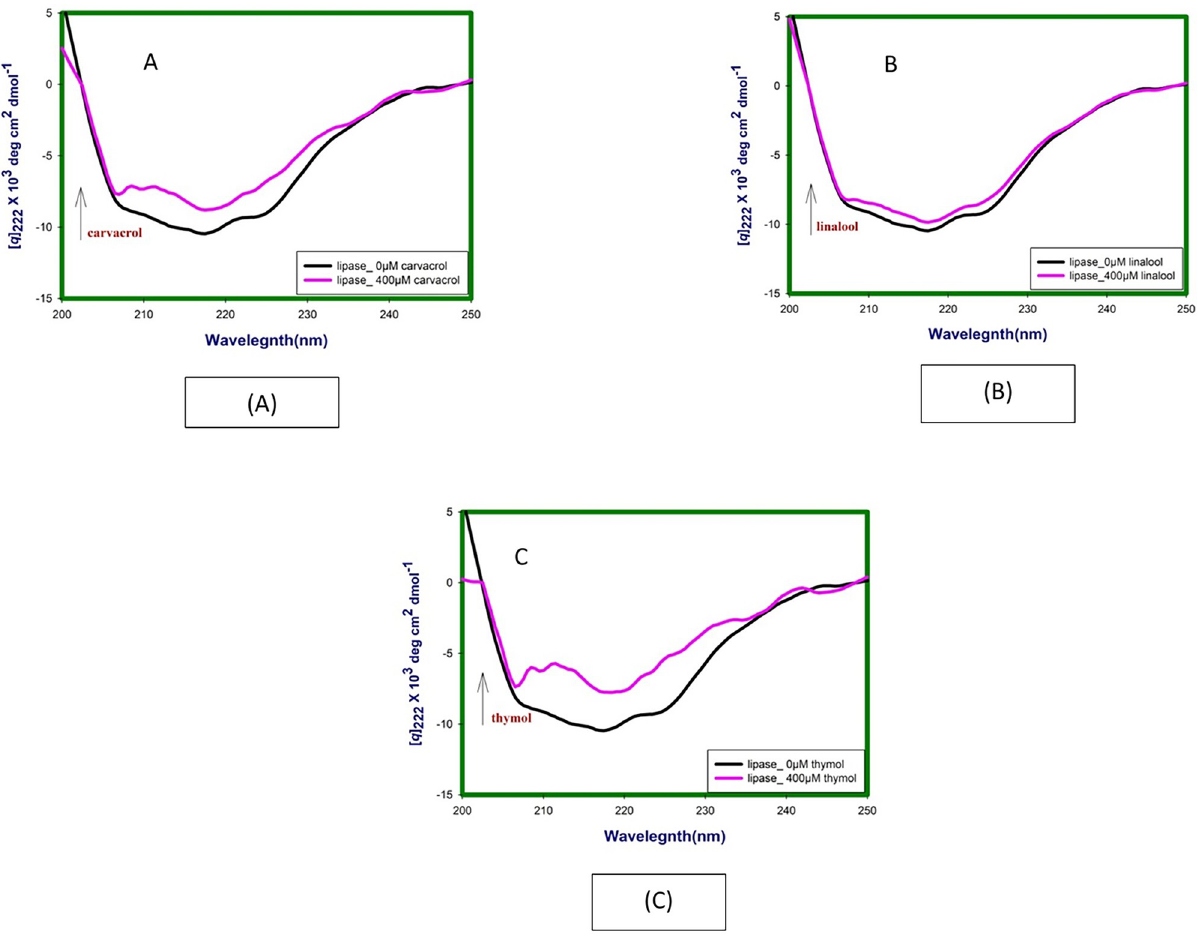
Fig 8. Far-UV CD spectra at 24hrs lipase in absence and presence of (A) linalool, (B) carvacrol and (C) thymol at 298.15 K and pH 7.4.